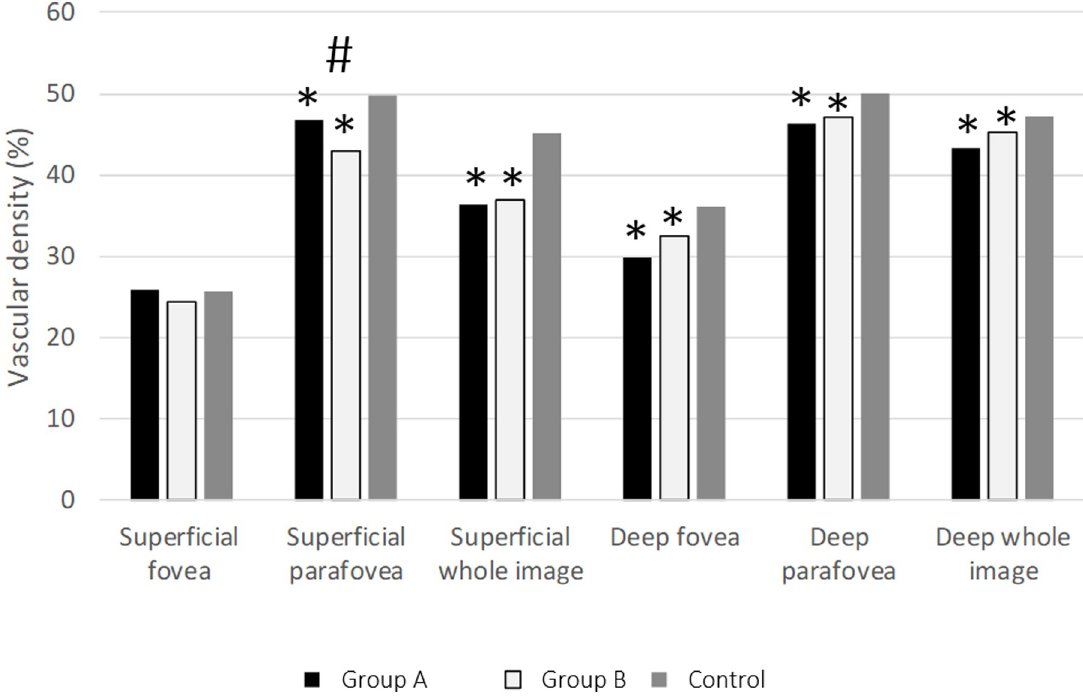
Fig 2. Diagram of the mean of superficial and deep retinal vascular density in all groups. � p < 0.05 from the control group, †p < 0.05 between Group A and B.